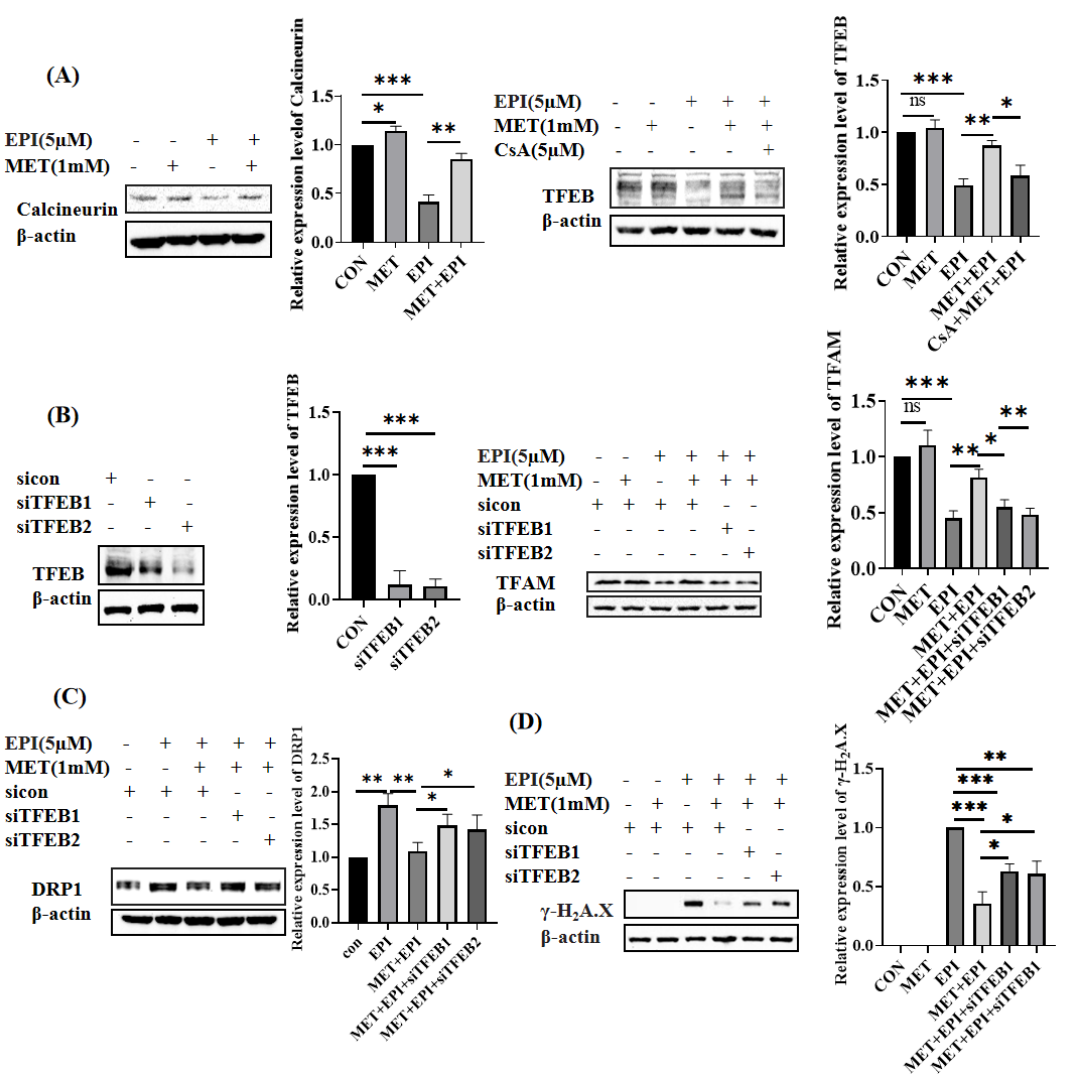
Figure 4. Metformin restores mitochondrial homeostasis via calcineurin/TFEB. ( A ) Metformin restores the calcineurin/TFEB pathway. HUVEC cells were treated with 5 µ M epirubicin for 24 h with pretreatment of 1 mM metformin for 12 h or 5 µ M CsA for 2 h, respectively. The expression levels of calcineurin and TFEB were detected by Western blotting. ( B ) Expression levels of TFAM. The expression of TFEB in HUVEC cells was inhibited by siRNA. Then, HUVEC cells were treated with 5 µ M epirubicin for 12 h with or without the pretreatment of 1 mM metformin for 12 h. Western blotting was used to measure the TFAM expression. ( C ) Expression levels of DRP1. The expression of TFEB in HUVEC cells was inhibited by siRNA. Then, HUVEC cells were treated with 5 µ M epirubicin for 24 h with or without the pretreatment of 1 mM metformin for 12 h. DRP1 expression was detected by Western blotting. ( D ) Expression levels of γ − H2A.X. The expression of TFEB in HUVEC cells was inhibited by siRNA. Then, HUVEC cells were treated with 5 µ M epirubicin for 24 h with or without the pretreatment of 1 mM metformin for 12 h. Levels of γ − H2A.X were detected by Western blotting. The epirubicin treatment group was used as the reference. EPI—epirubicin, MET—metformin, ns—not significant, * p < 0.05, ** p < 0.01, *** p <